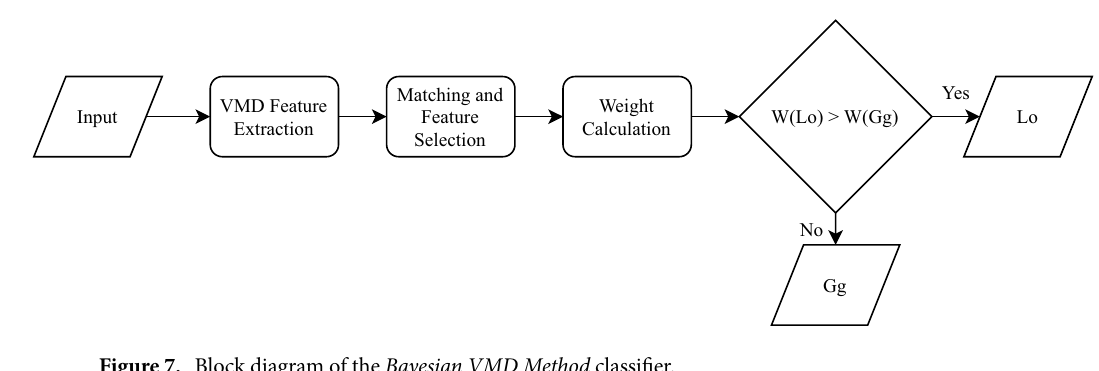
Figure 7. Block diagram of the Bayesian VMD Method